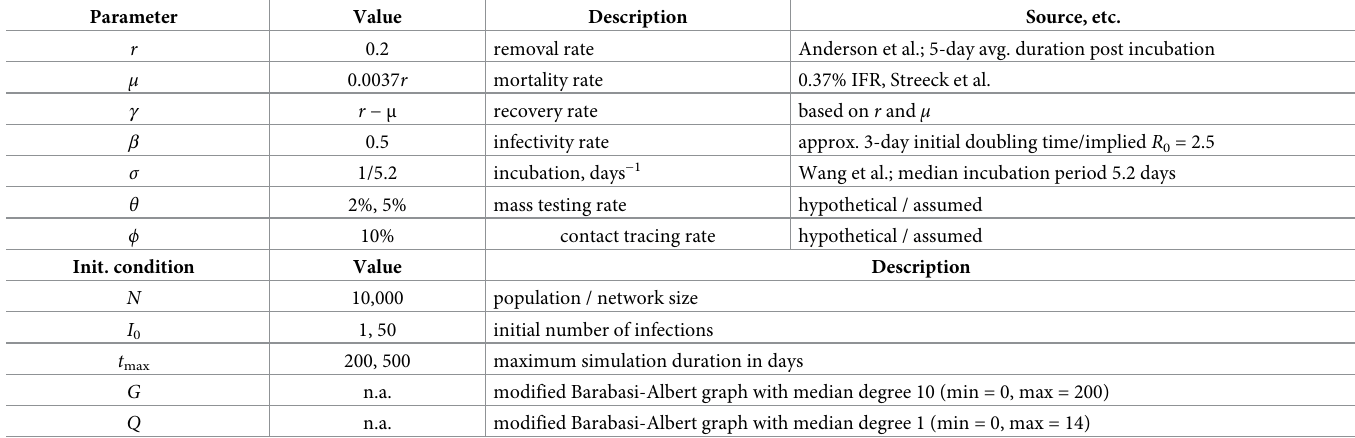
Table 1. Baseline parameter values and initial